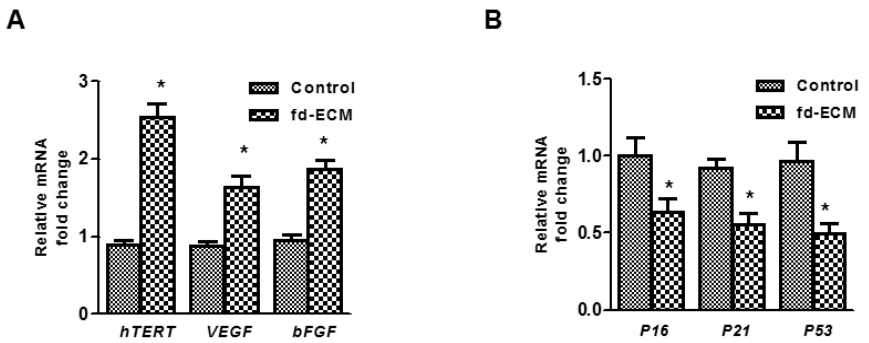
Figure 9. Cont. Figure 9. Cont.